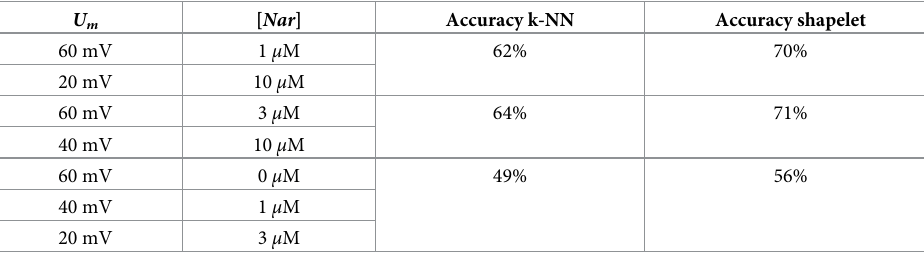
Table 2. The prediction accuracies obtained with the k-NN and shapelet learning method for dwell-time sequences corresponding to different groups of recordings marked by various shades of gray in Table